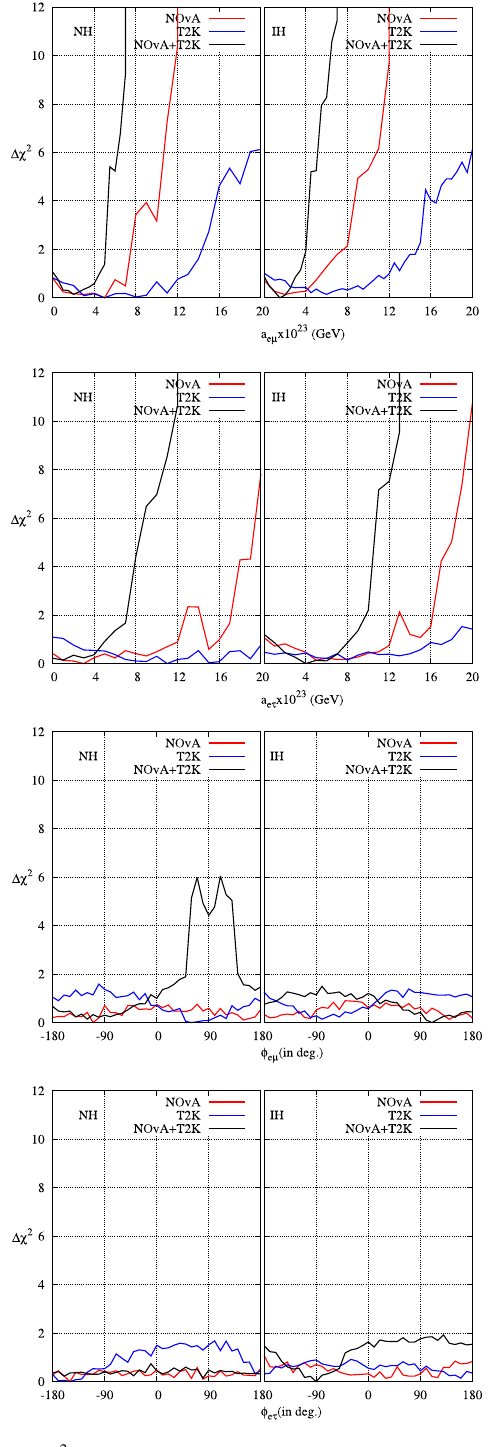
Fig. 11 (cid:6)χ 2 as a function of individual LIV parameters